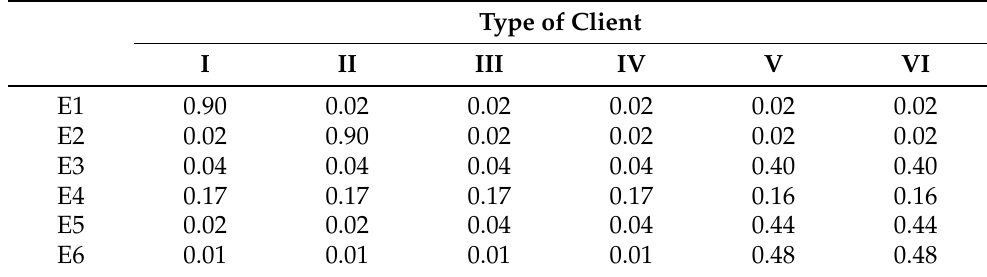
Table 4. Definition of different federated